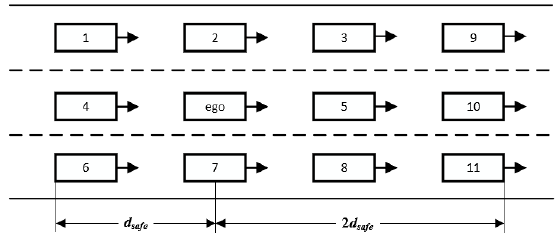
Figure 4. DOI based on safety distance [116].